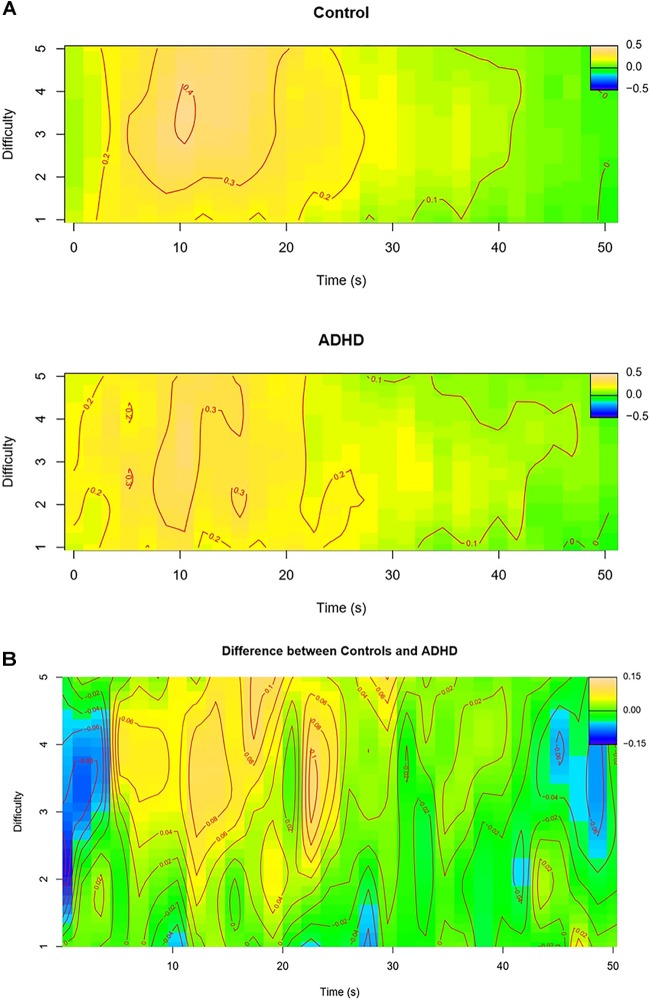
Difference surface plots for pupil responses during N-back tasks. (A) Surface plots for the control and ADHD group separately, showing that peak pupil dilation occurs within approximately 10 s after task onset (yellow-red areas), and appears highest for the control group for intermediate levels of difficulty (3-, 4-back), and is more diffuse for the ADHD group across levels of difficulty. (B) Surface plot showing the difference in pupil size between the control and ADHD group, which is most apparent on intermediate and higher levels of difficulty (3-, 4-back) between 5 and 25 s after task onset (yellow–red areas; controls > ADHD) (blue areas: ADHD > controls).